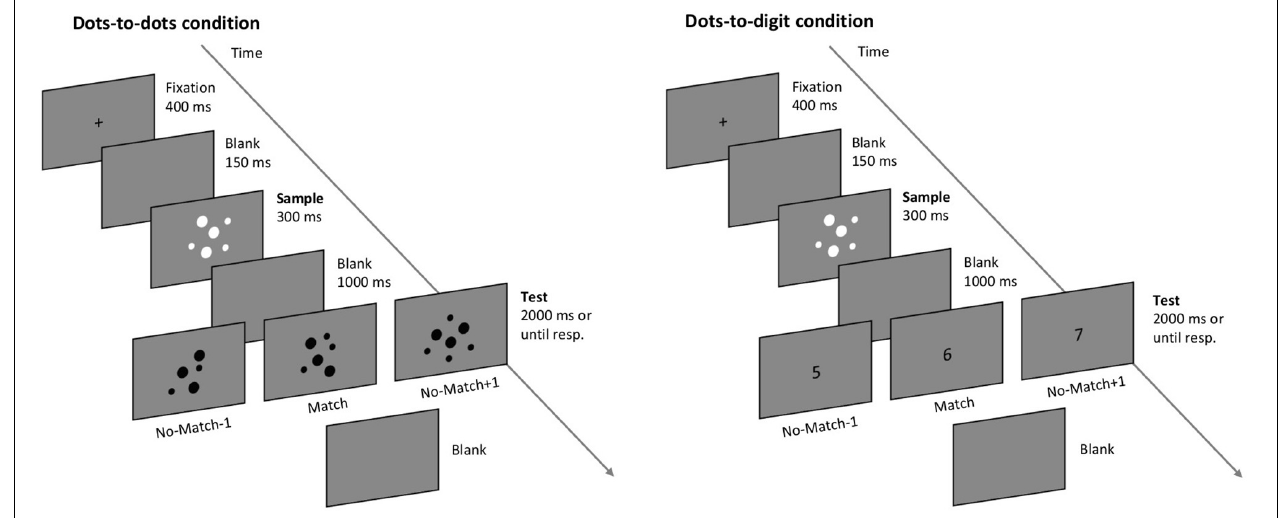
FIGURE 1 | Depiction of the match-to-sample paradigm. The participants were asked to decide if the numerosity of the second test stimulus matched the numerosity of a sample dot array. In the dots-to-dots condition, the test stimulus consisted of a dot-array, while in the dots-to-digit condition the test stimulus was an Arabic